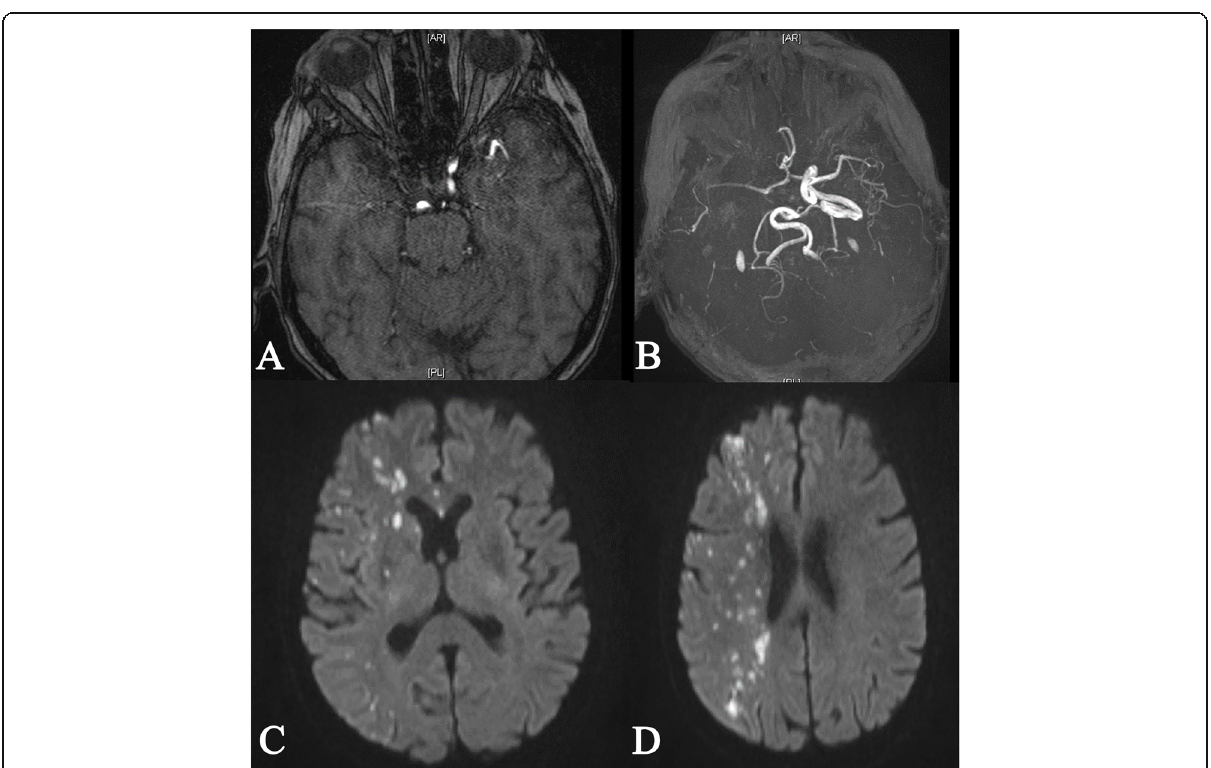
Fig. 2 a-d: MRI of the same patient demonstrates occlusion of right ICA with subsequent multiple ischemic infarcts along right MCA territory